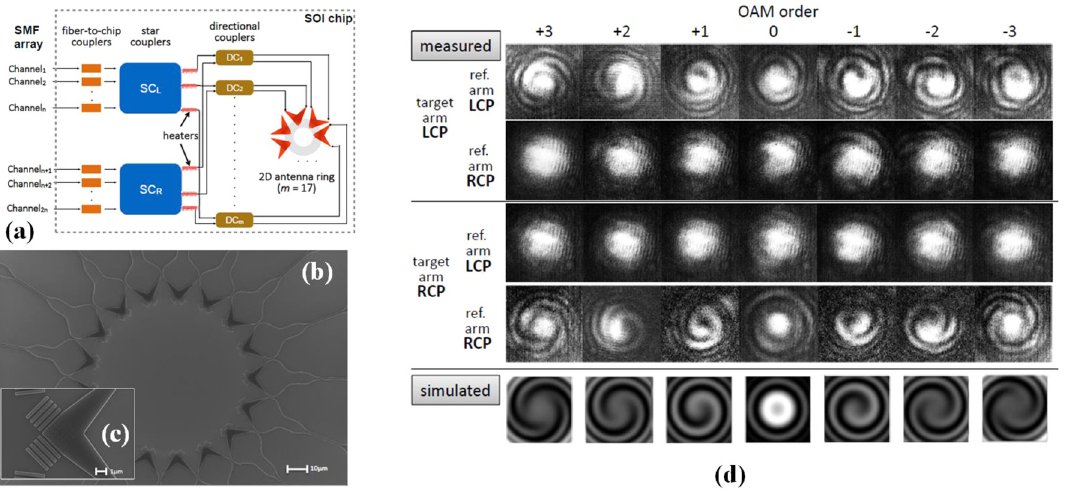
Figure24: (a)BlockdiagramofanOAMgenerator/multiplexer;(b)Scanningeletronmicroscopy(SEM)imageofthefabricatedemittersection; (c) SEM image of a 2D grating coupler; (d) measured interferograms for different OAM orders [262]. OAM, orbital angular momentum.